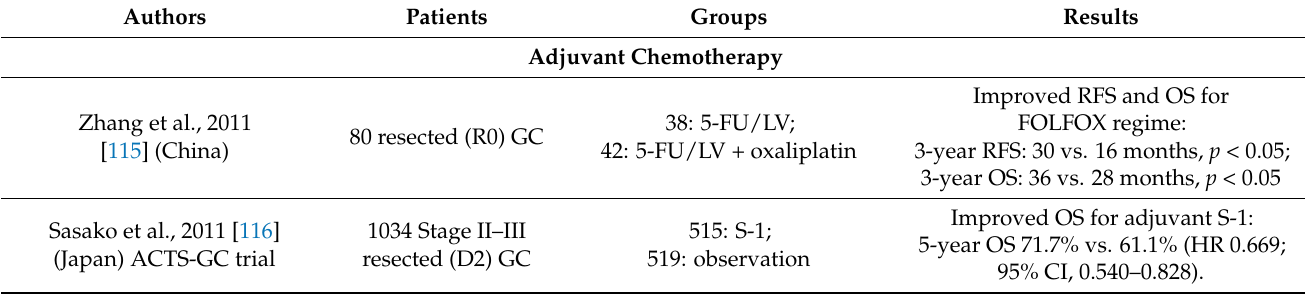
Table 4. Key trials on adjuvant chemotherapy and chemoradiotherapy for gastric